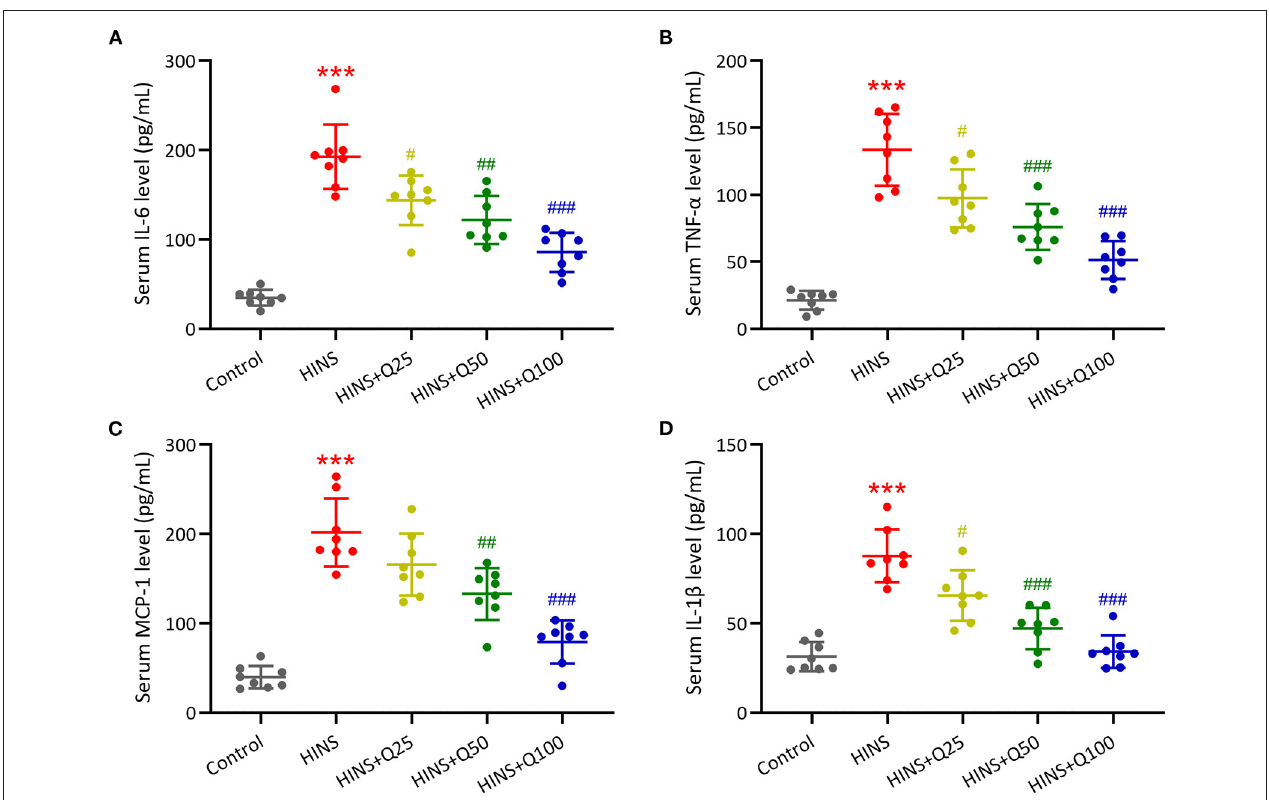
FIGURE 4 | Quercetin administration following HINS attenuated serum inflammatory cytokines. ELISA was used to measure the concentrations of IL-6 (A) , TNF- α (B) , MCP-1 (C) , and IL-1 β (D) in serum of rats from different groups. Eight rats were used in each group. Mean ± SD. *** p < 0.001 compared to control. # p < 0.05, ## p < 0.01, and ### p < 0.001 compared to